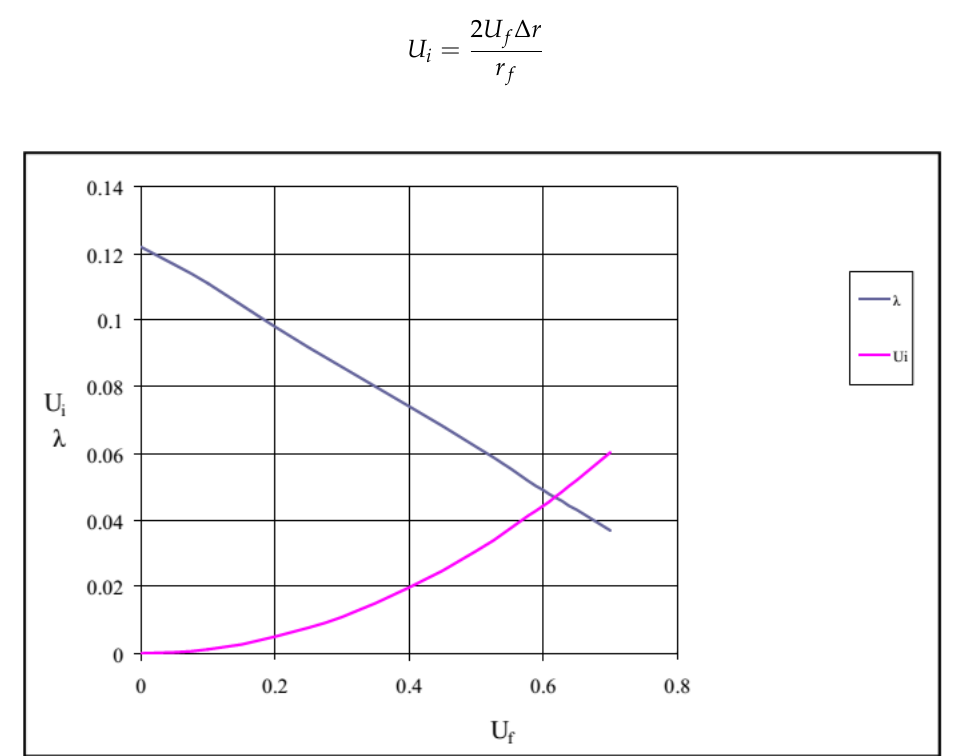
Figure 2. Variation of interphase content and parameter λ versus filler